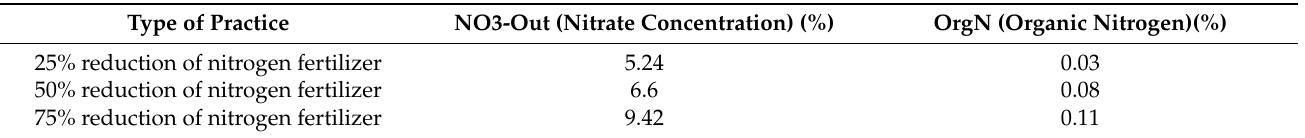
Table 5. Percentage reduction in organic nitrogen and nitrate concentrations at varying reductions of nitrogen fertilizer.